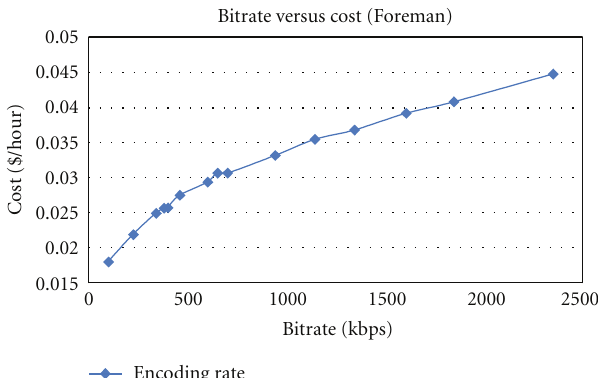
Figure 2: Bitrate versus Encoding speed